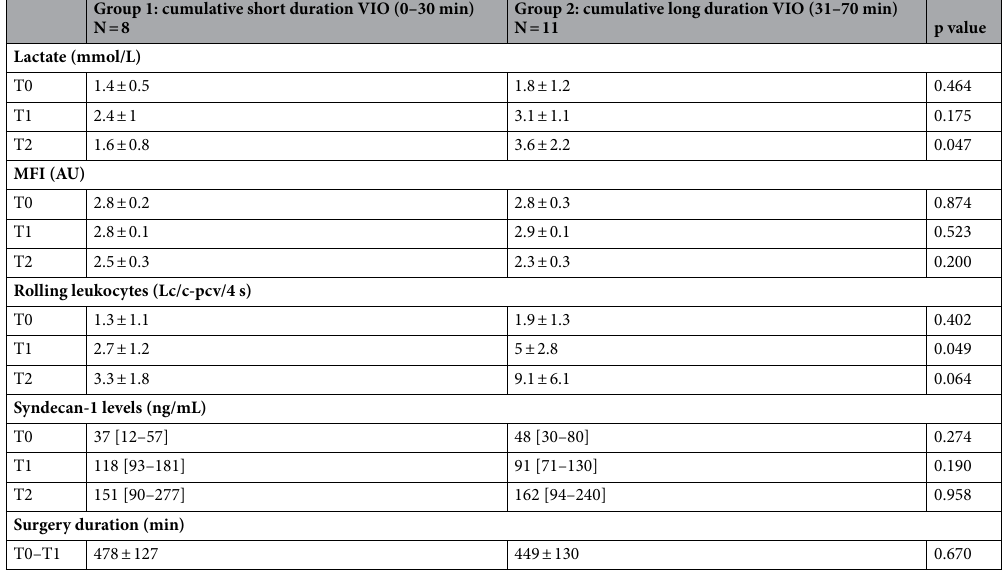
Table 4. Higher rolling leukocytes and lactate values in patients with long vascular inflow occlusion (VIO) duration. T0 at the beginning of surgery, T1 at the end of surgery, T2 24 h after surgery, MFI microvascular flow